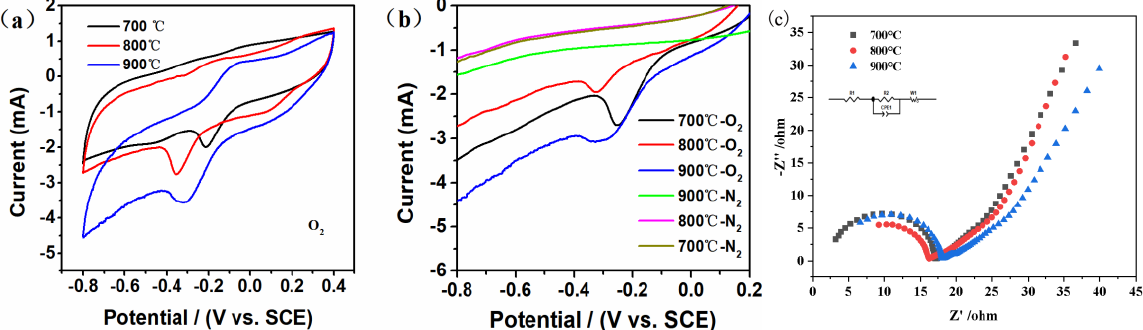
Figure 5. Electrochemical performance evaluation of the Co−N−C electrode synthesized at 700 °C, 800 °C and 900 °C under oxygen saturation condition. ( a ) CV, ( b ) LSV and ( c ) AC impedance spectroscopy.